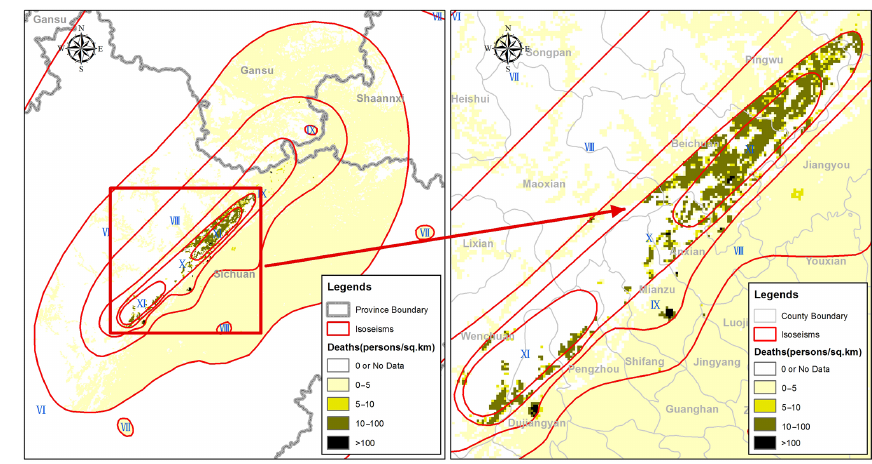
Figure 9. Predictions of the spatial distribution of potential deaths for the Wenchuan